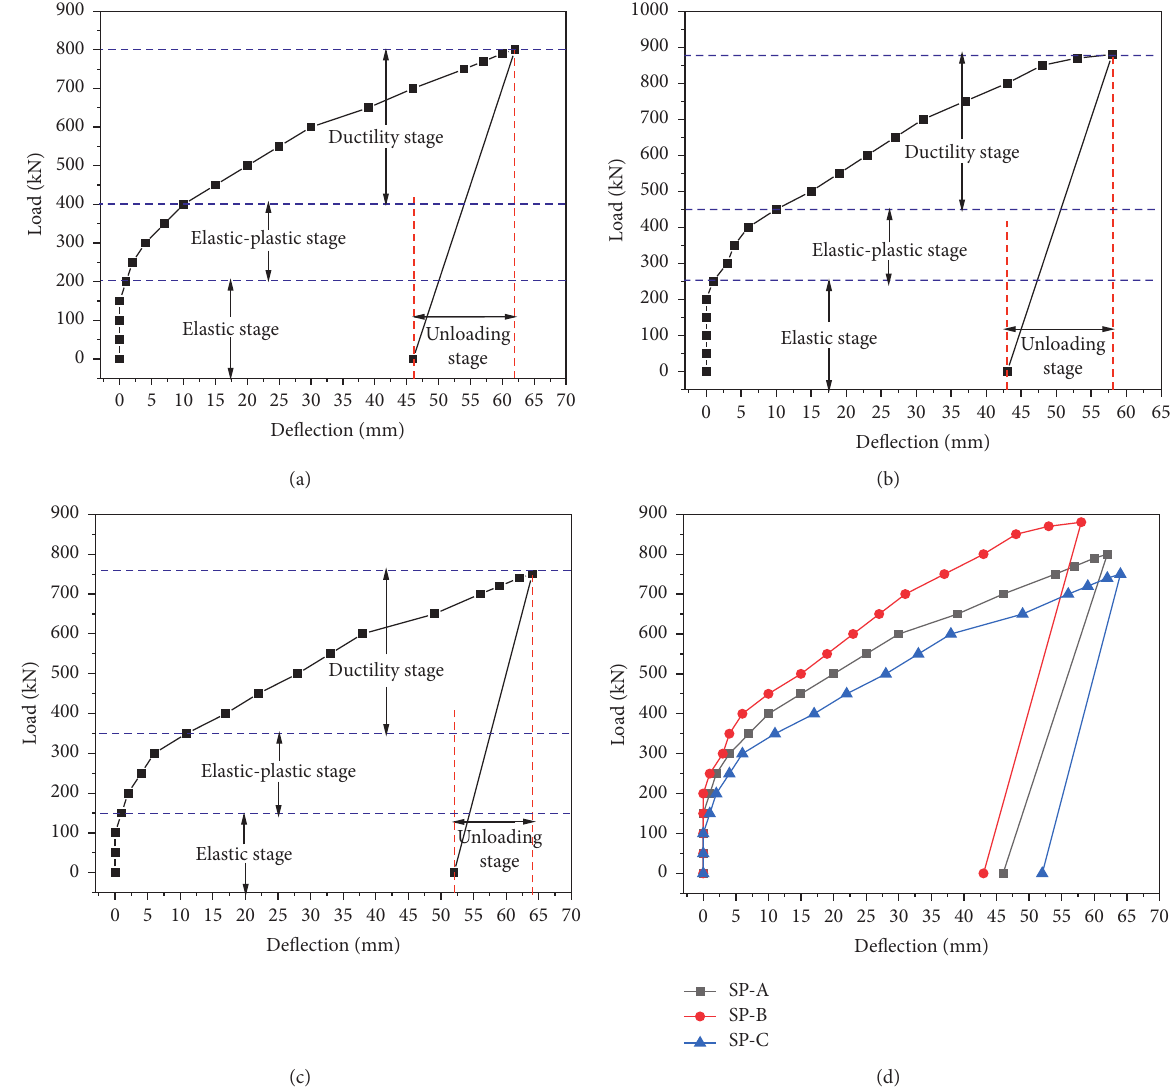
Figure 6: Load-deflection curves. (a) SP-A. (b) SP-B. (c) SP-C. (d) SP-A, SP-B, and